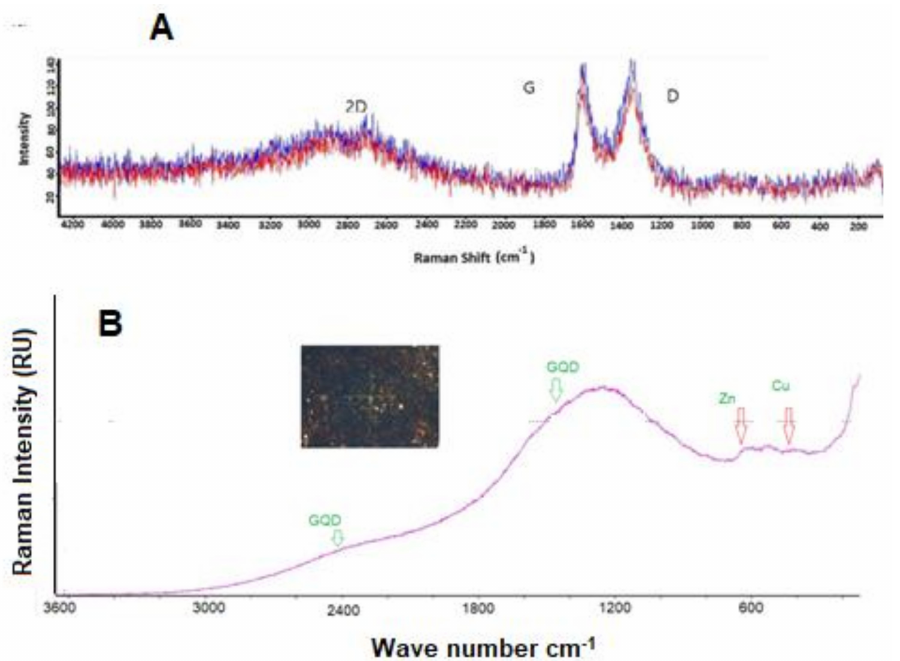
Figure 5. Raman spectrum of the electrochemically prepared composite GQD before ( A ) and after deposition of the composite ( B